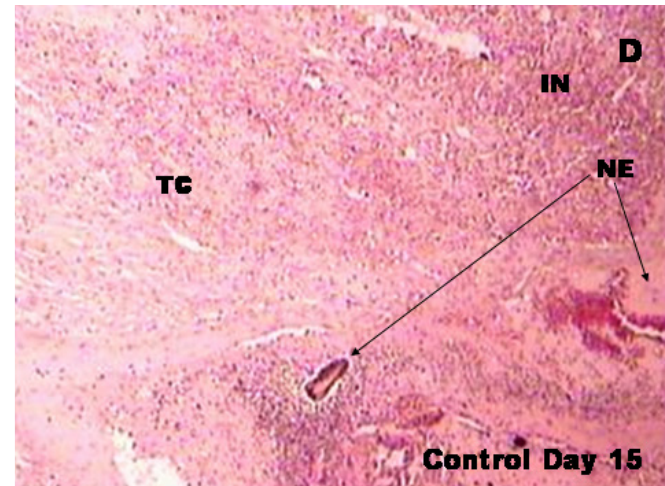
FIGURE 5 - Control group at Day 15. The dermis shows connective tissue (TC) focal areas of inflammatory process (IN) and necrosis